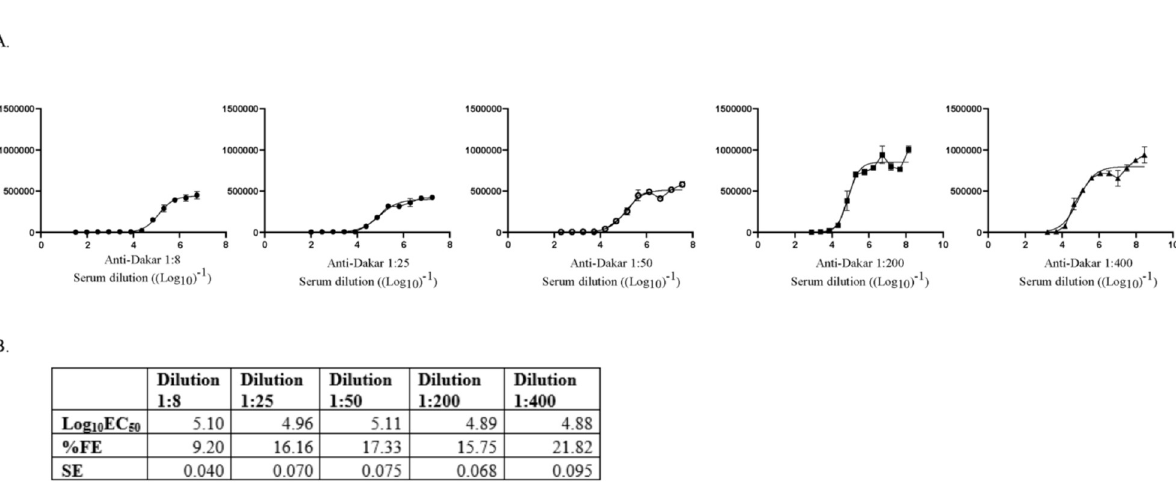
Fig 8. Determination of the ULOQ of Z-RVP-384 assay. (A) Neutralization curves of several dilutions of high potency rabbit serum in assay media to estimate the ULOQ for the standard assay. A rabbit hyperimmune serum generated by immunization with live ZIKV (Dakar) was diluted in assay media 1:8, 1:25, 1:50, 1:200, and 1:400. (B ) log 10 EC 50 titers generated by each serum dilution shown with Standard error (SE) of the log 10 EC 50 estimate and % FE (SE � LN(10) � 100).